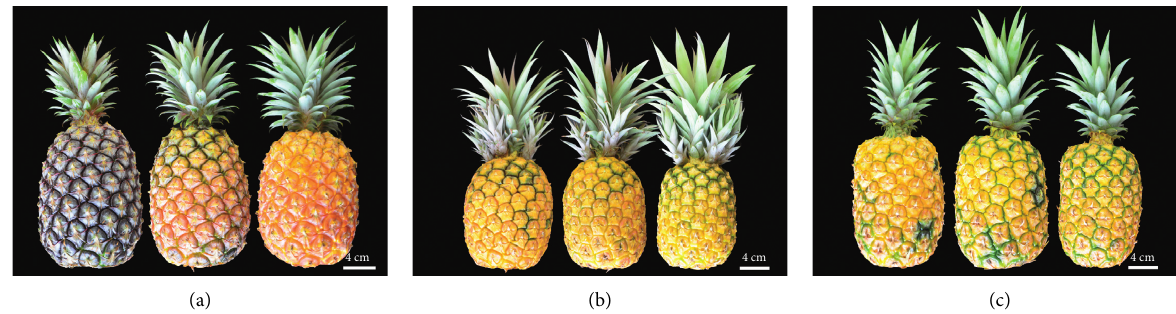
Figure 3: Fruits of the three pineapple cultivars harvested from established crops under three different sowing densities. (a) Smooth Cayenne, (b) Santa Rosa ecotype, and (c) Golden. Table 2: Effect of sowing density on the physical characteristics of three pineapple cultivars. Treatments